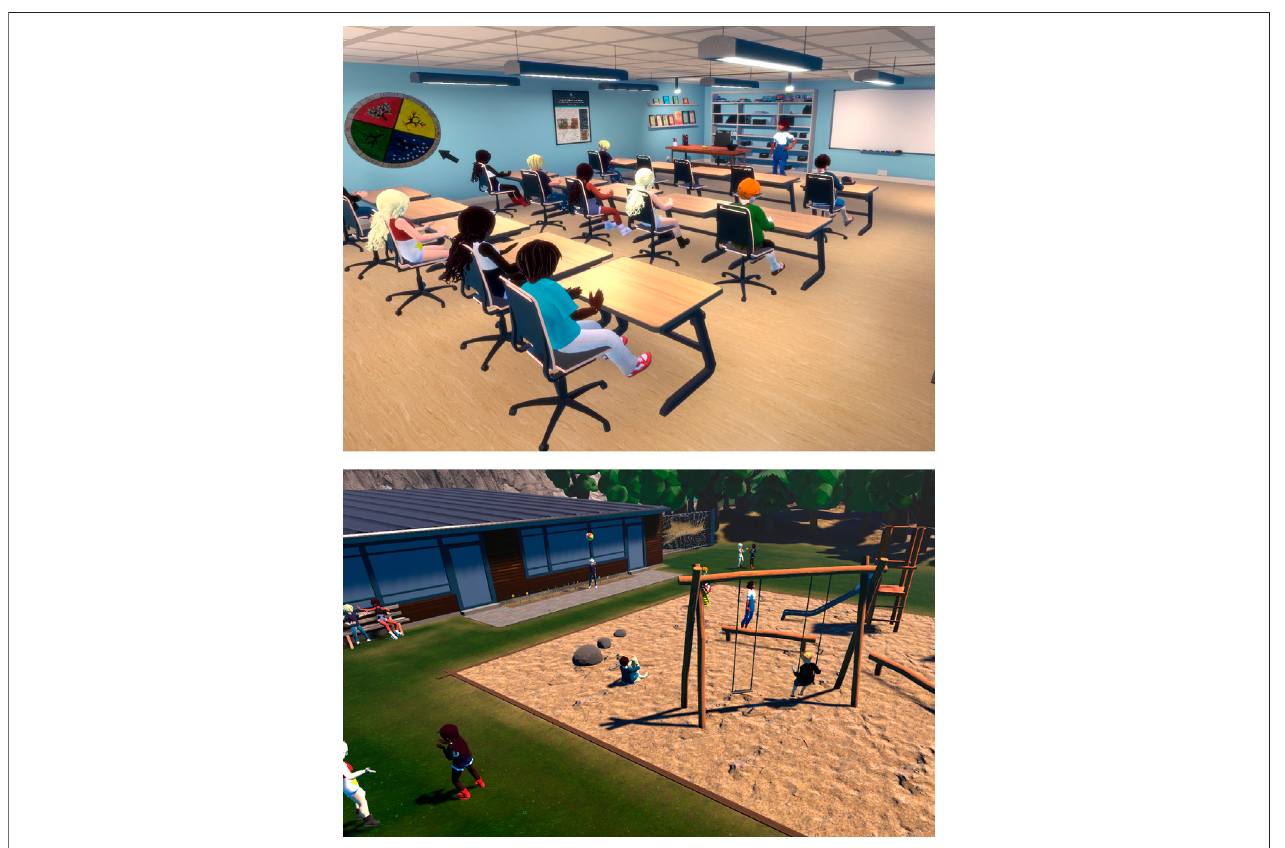
FIGURE 1 | The inside and outside